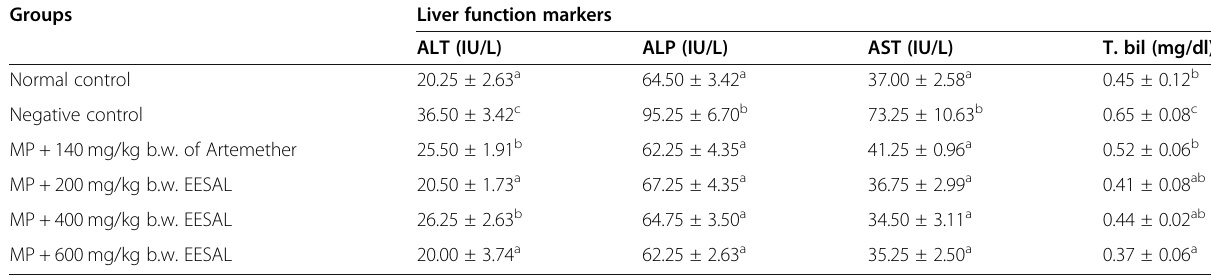
Table 5 Effect of the EESAL on the liver function parameters in Plasmodium berghei -infected mice